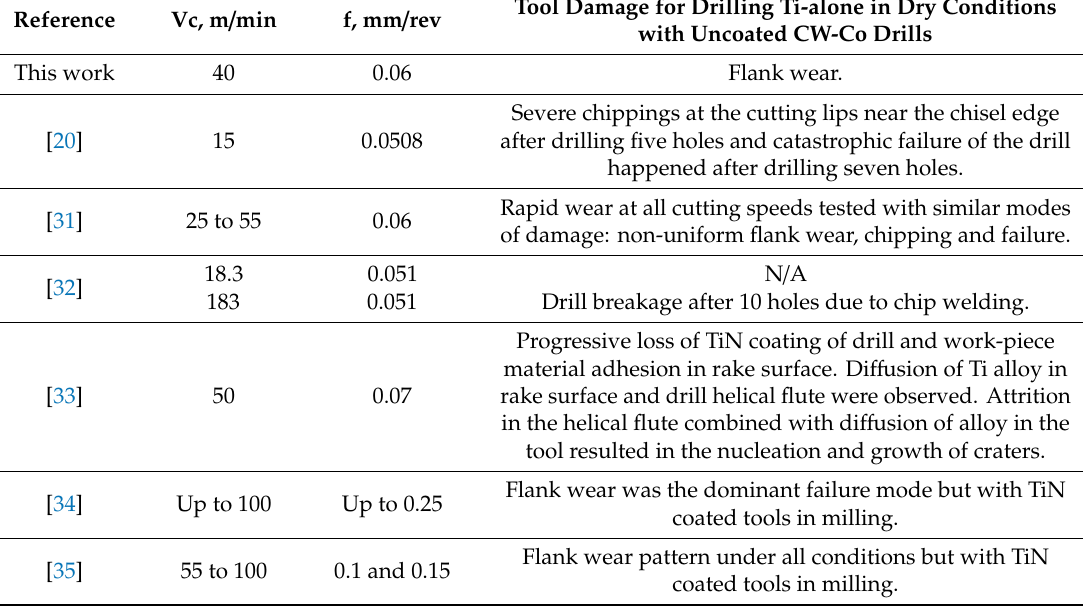
Table 2. Comparison of the failure modes when drilling Ti-alone plates in dry conditions and a comparison with literature